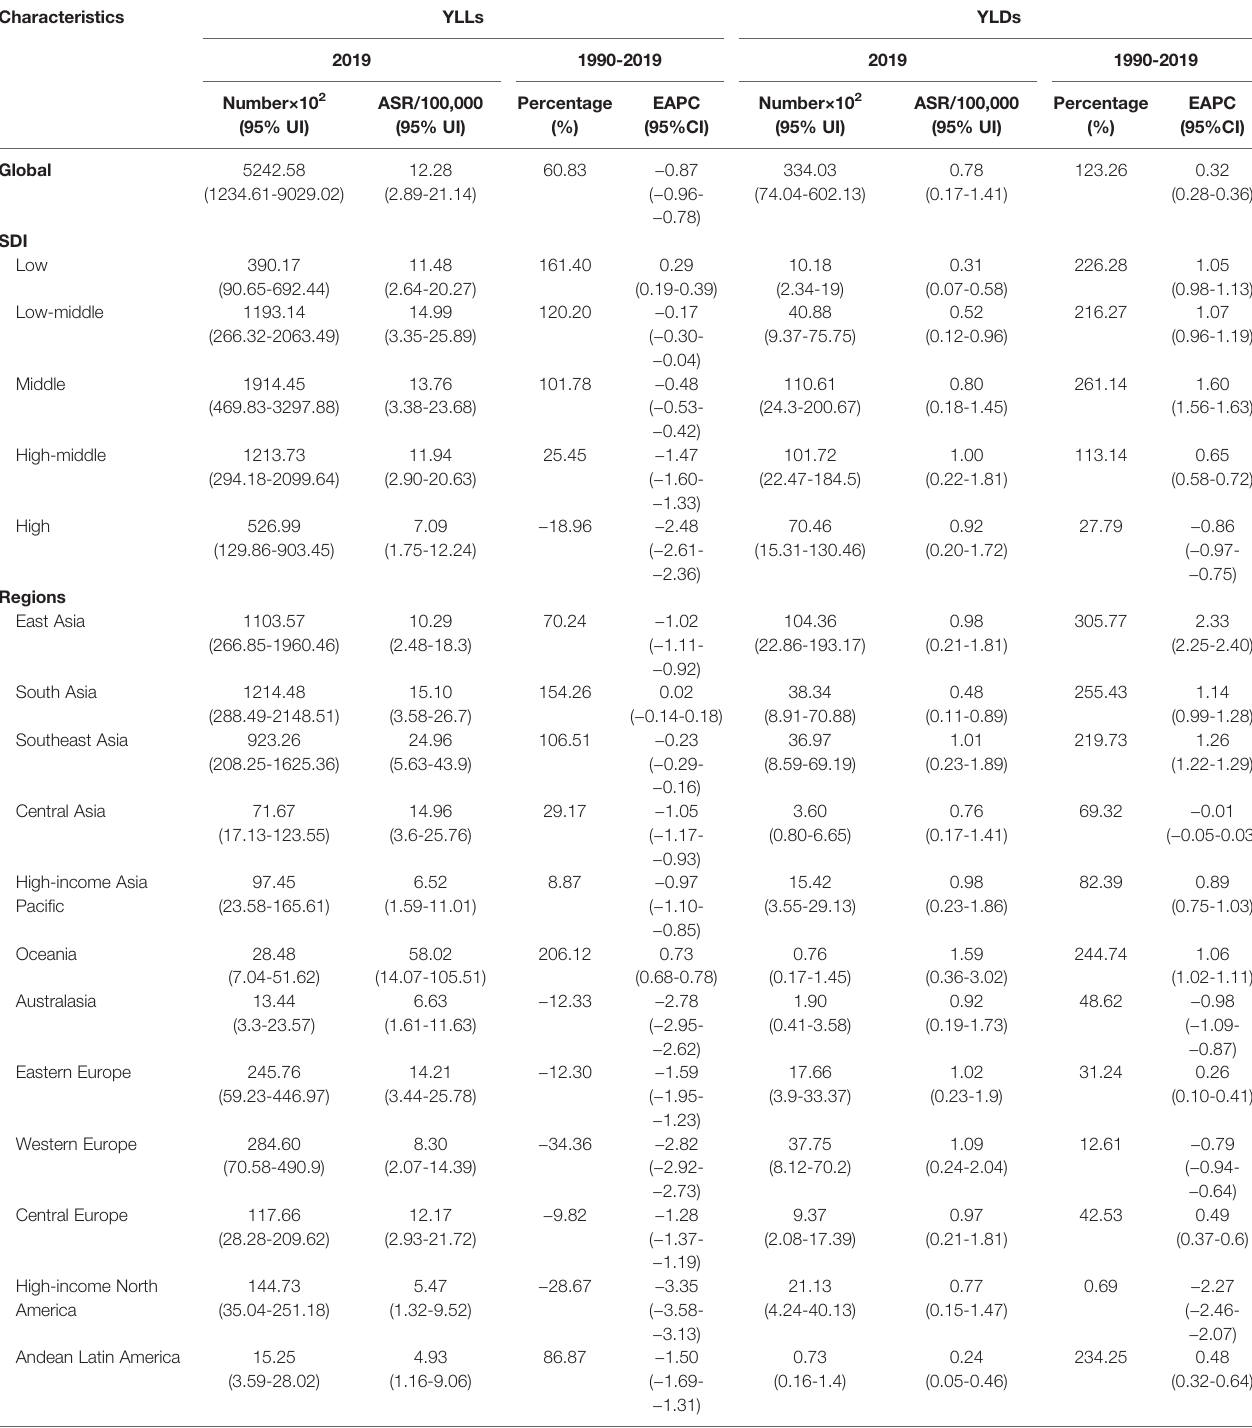
TABLE 2 | the characteristics and trends of YLLs and YLDs caused by breast cancer attributable to secondhand smoke in global, SDI areas and geographic regions, 1990-2019.